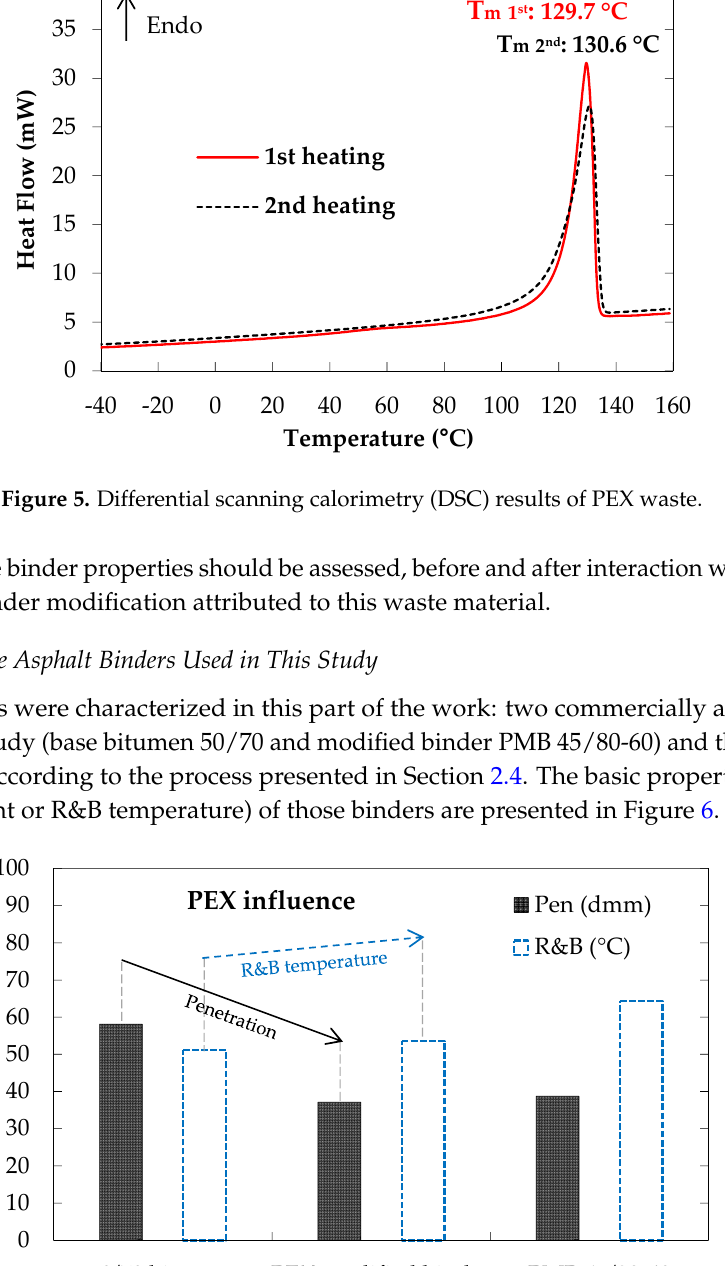
Figure 6. Basic properties of the asphalt binders used in this study, including the PEX modified binder.